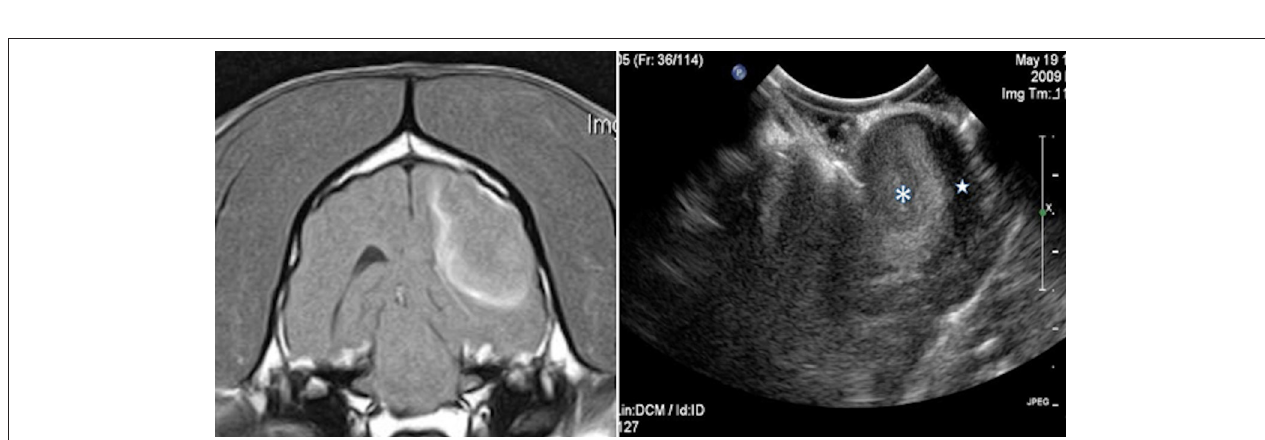
FIGURE 4 | Case 29. There is an ovoid, sharply marginated, 1.46 × 0.81cm (MRI)/1.49 × 0.85cm (US), heterogeneous mass present to the right and adjacent to midline, which is largely hyperechoic to brain parenchyma, but also contains a few hypoechoic regions within. There is a mild leftward midline shift of the brain parenchyma as a result of this mass. Microscopic examination of this mass revealed a grade 1 transitional meningioma.